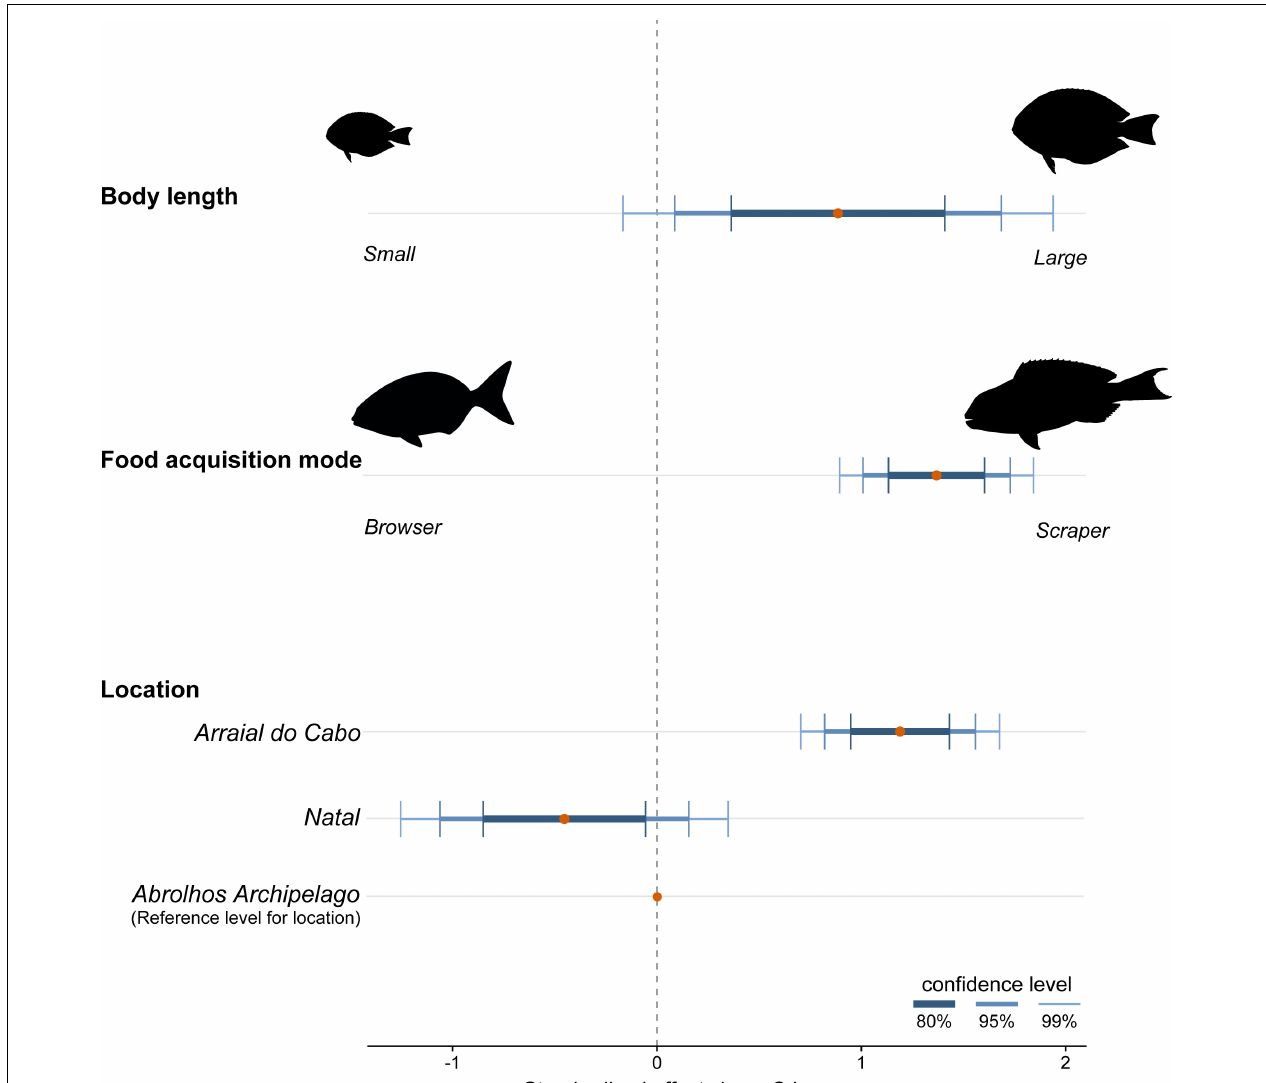
FIGURE 4 | Effect sizes and confidence interval at three levels (80, 95, and 99%) of significance resulted from the zero-inflated Poisson generalized linear model testing the effect of body length, food acquisition mode, and location on the number of debris